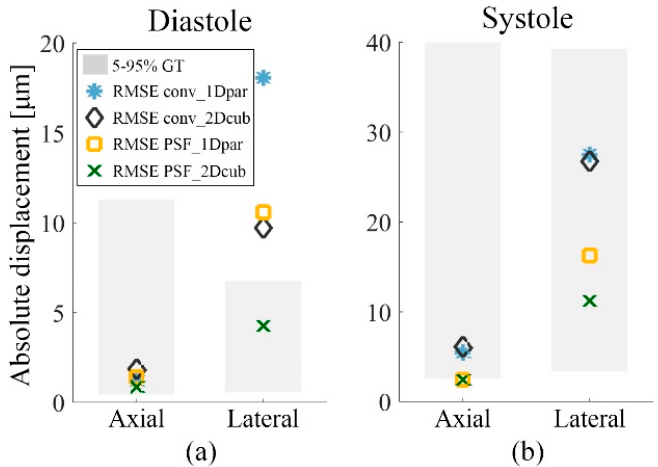
Figure 7. Root-mean-squared error (RMSE) values for the axial and lateral inter-frame displacement estimates obtained using the four different methods. Results are visualized for the diastolic ( a ) and systolic ( b ) phase. Absolute inter-frame ground truth (GT) 5–95% displacement ranges are also included in the figure. Please note the axial GT bar is cut off at 40 µm, while it ends at 72 µm.